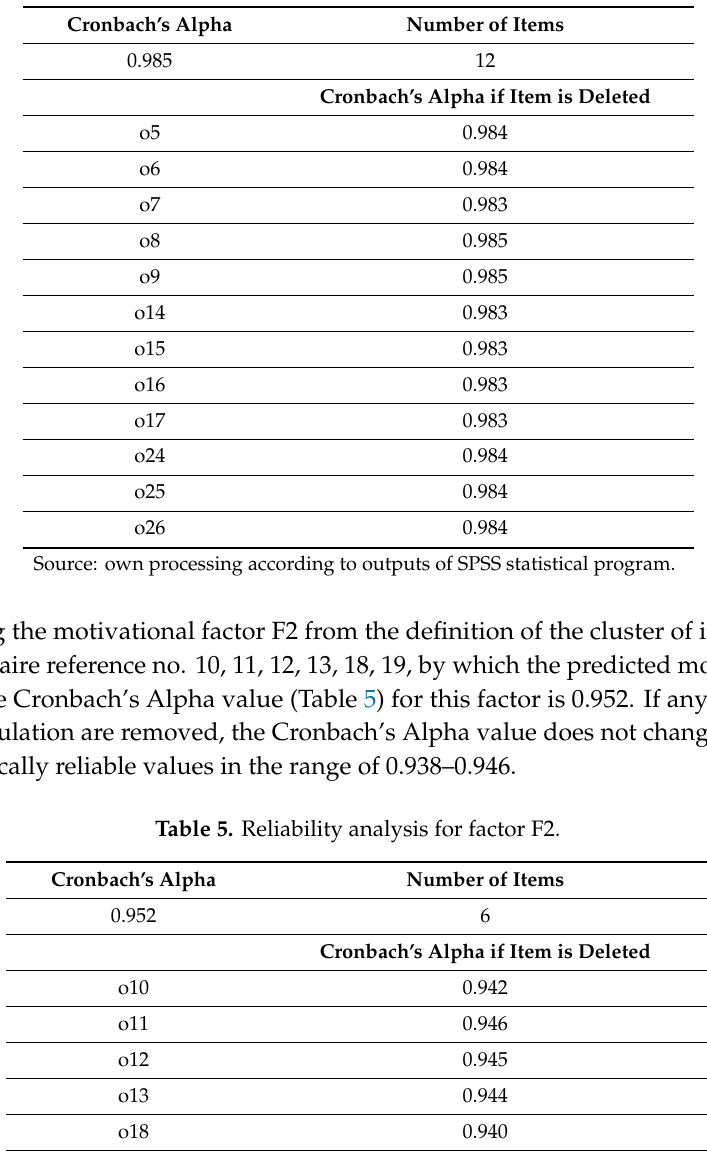
Table 4. Reliability analysis for F1 factor.